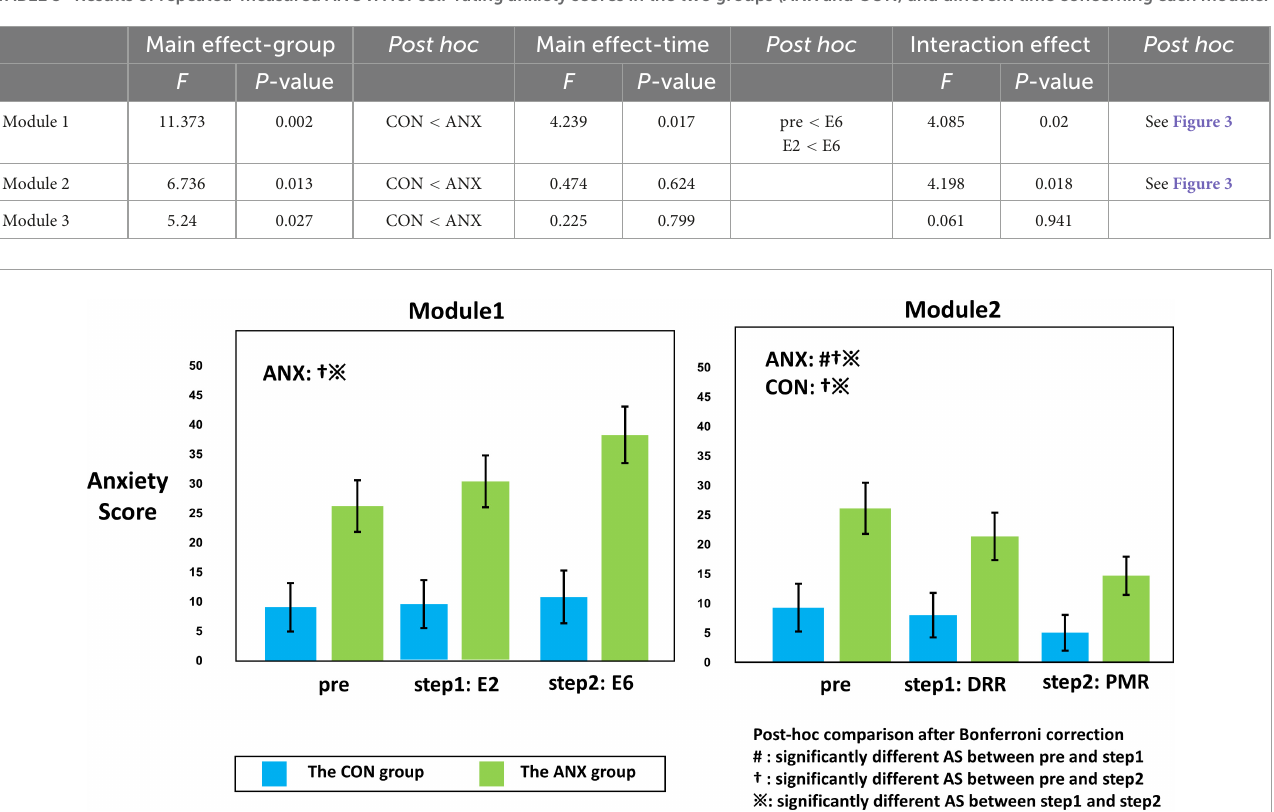
TABLE 3 Results of repeated-measured ANOVA for self-rating anxiety scores in the two groups (ANX and CON) and different time concerning each module.